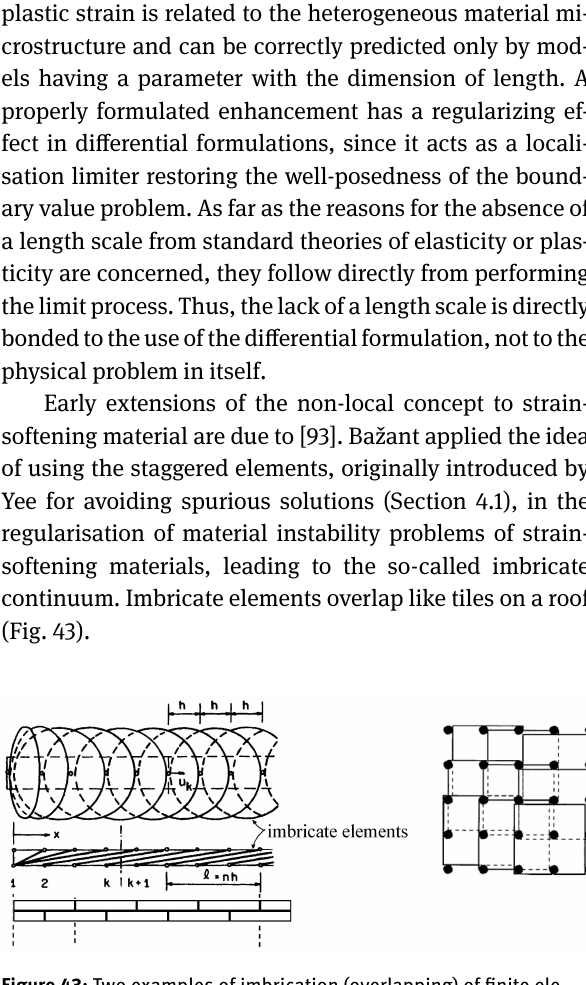
Figure 43: Two examples of imbrication (overlapping) of finite ele- ments